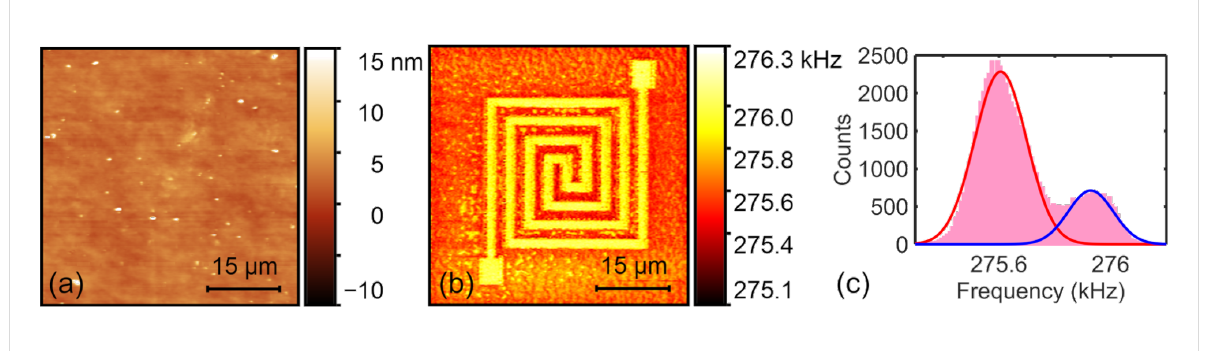
Figure 2: Subsurface imaging of the flexible circuit sample with a top layer thickness of 52 nm measured via the CR-AFM method. (a) Topography. (b) The first contact resonance frequency. (c) Histogram of the resonance frequency image. The results were obtained by using the PPP-FM probe under a normal force of 74